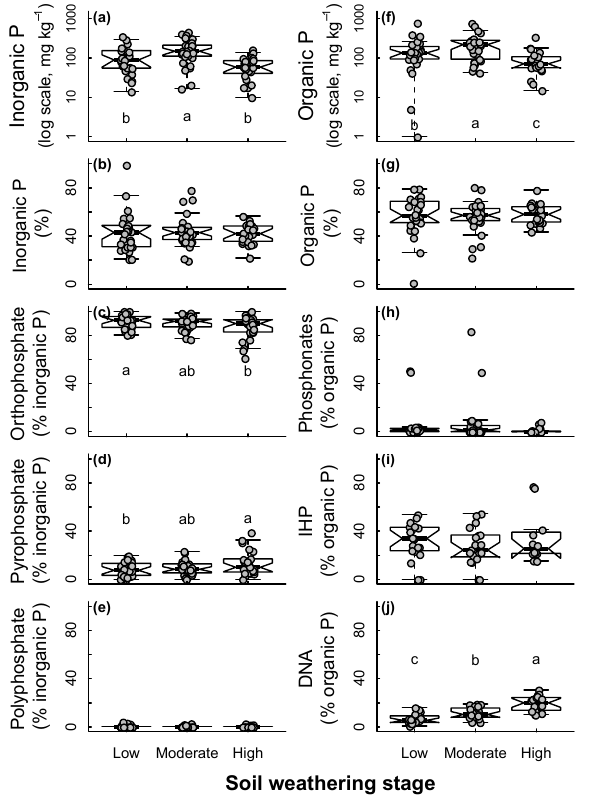
Figure 5. Soil inorganic and organic phosphorus (P) composition in NaOH-EDTA extract as influenced by weathering stages on natural